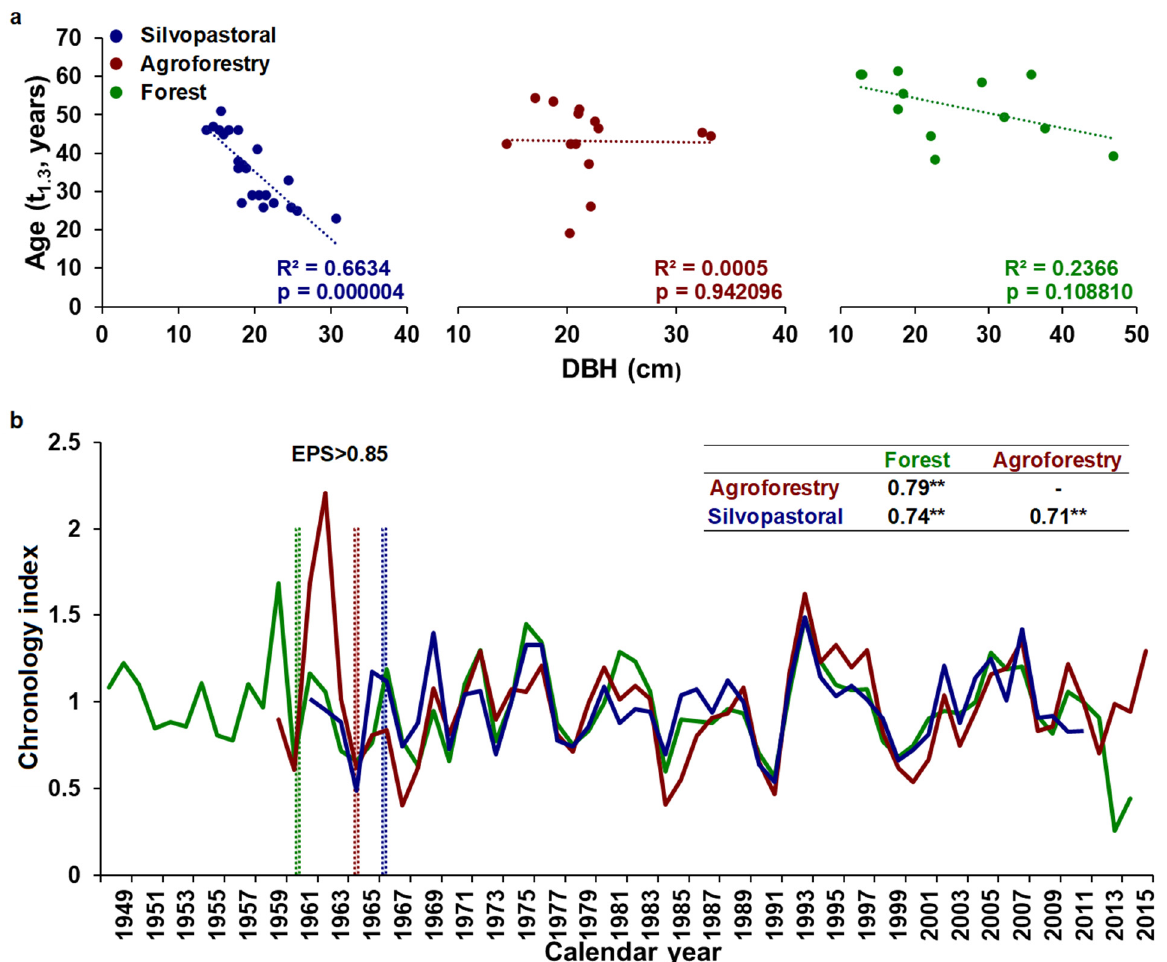
Figure 4. ( a ) Relationship between diameter at breast height (DBH, cm) and tree age (t 1.3 , number of tree-rings at breast height) for all the three sites; ( b ) site-specific TRW chronologies for silvopastoral (Shahanshah, blue line), agroforestry (Mele-Shabanan, red line), and forest (Dadabad, green line). The vertical dashed lines indicate the first year with expressed population signal (EPS) > 0.85. The inset table shows the correlation coefficients between the three chronologies from years 1963–2011; the 99% significance level is denoted by two asterisks.